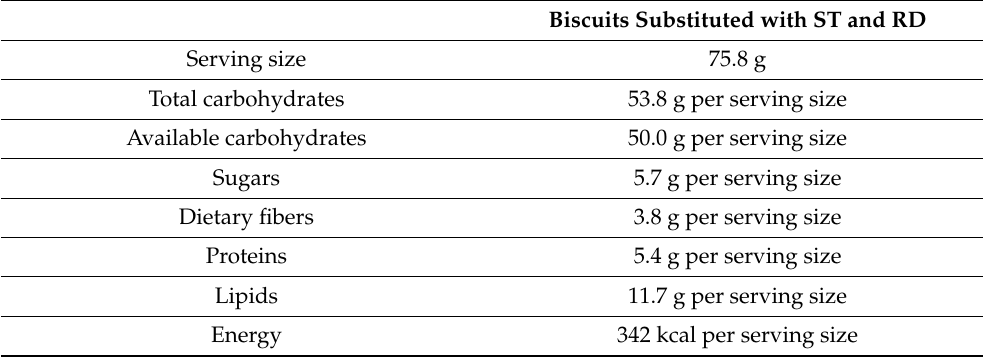
Table 3. Serving size of biscuits and nutrition composition per serving size for human